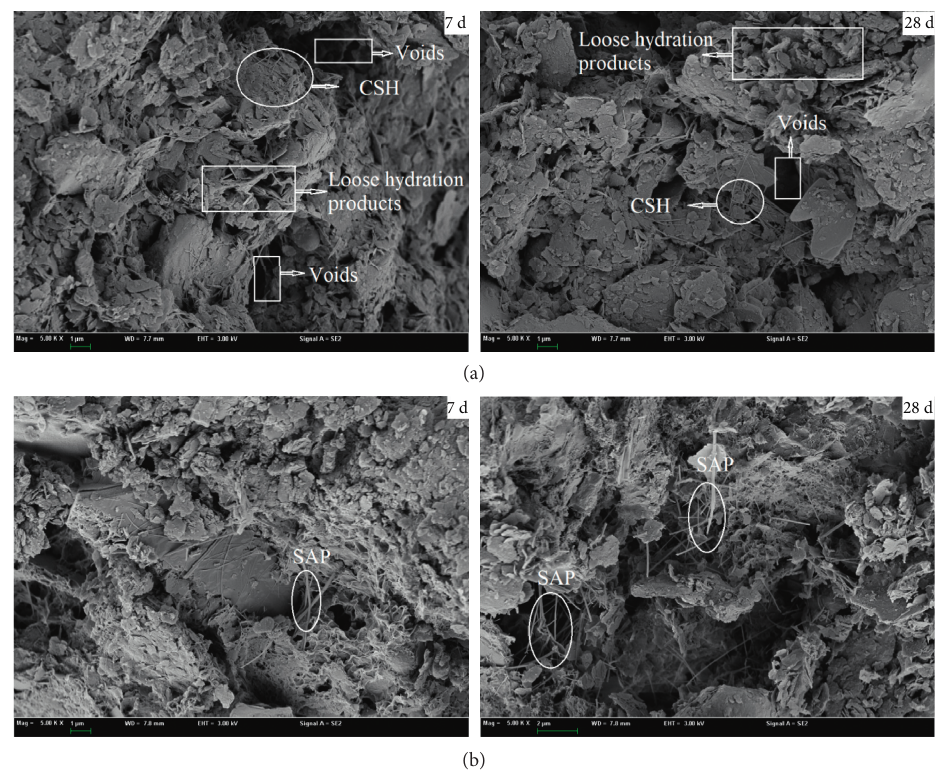
Figure 12: Scanning electron microscope images of the symbol with lime. (a) SEM images of L2C4. (b) SEM images of